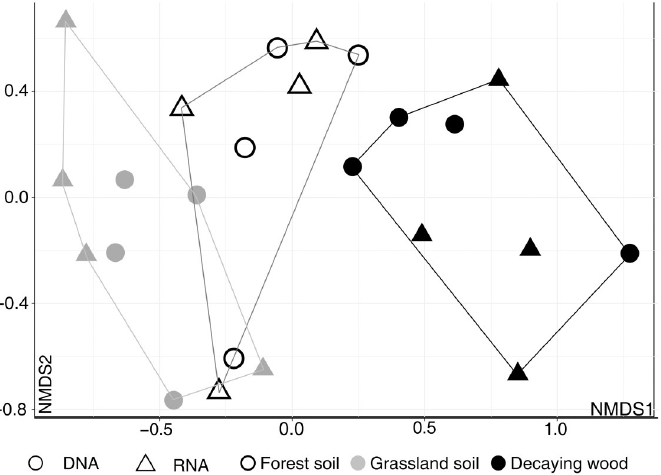
Fig 4. Non-Metric Multidimensional Scaling (NMDS) ordination of soil and decaying wood samples (DNA and RNA). Analysis was performed using MOTUs abundances in the “shared dataset” and Bray-Curtis indices. Convex hulls cluster samples according to habitat type. NMDS stress value = 0.048.